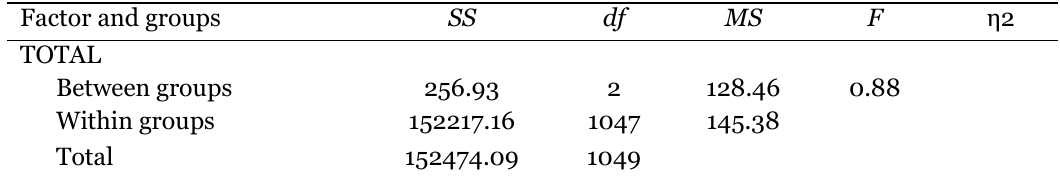
Analysis of Variance Statistics by Teaching